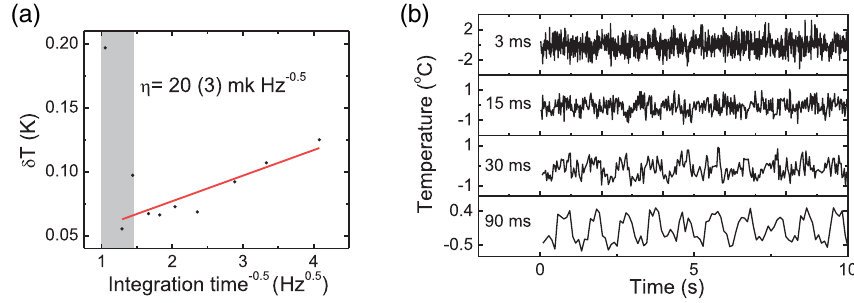
FIG. 5. Shot-noise-limited sensitivity and real-time temperature tracking at nanoscale. The hybrid sensor [the one in Fig. 4(a)] was used to monitor fast temperature variations at nanoscale. The local temperature was controlled by in situ laser heating, which has tunable amplitude. (a) Dependence of the temperature standard deviation on data acquisition time with the laser power (and hence temperature) kept constant. The shot-noise-limited sensitivity is derived from the slope of the curve. (b) With the laser power being modulated, the temperature variation (with frequency of 1 Hz and amplitude of 0 . 45 °C) was tracked with various acquisition time (3, 15, 30, and 90 ms per data point, from top to bottom). The 0 . 9 °C temperature variation is distinguishable with an integration time as small as 15 ms per data